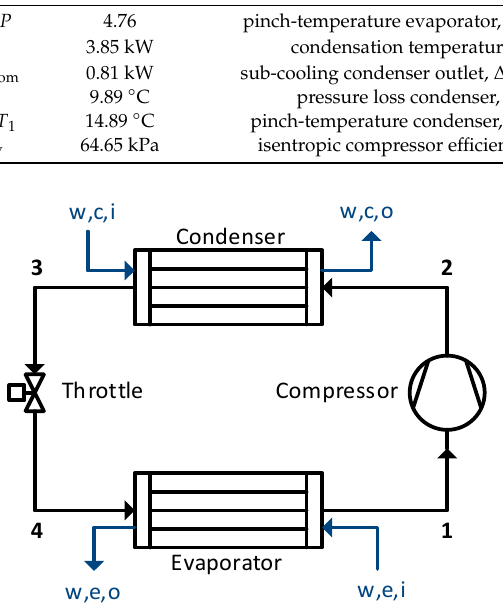
Figure 1. Heat pump scheme of the simulation models and the experiment.